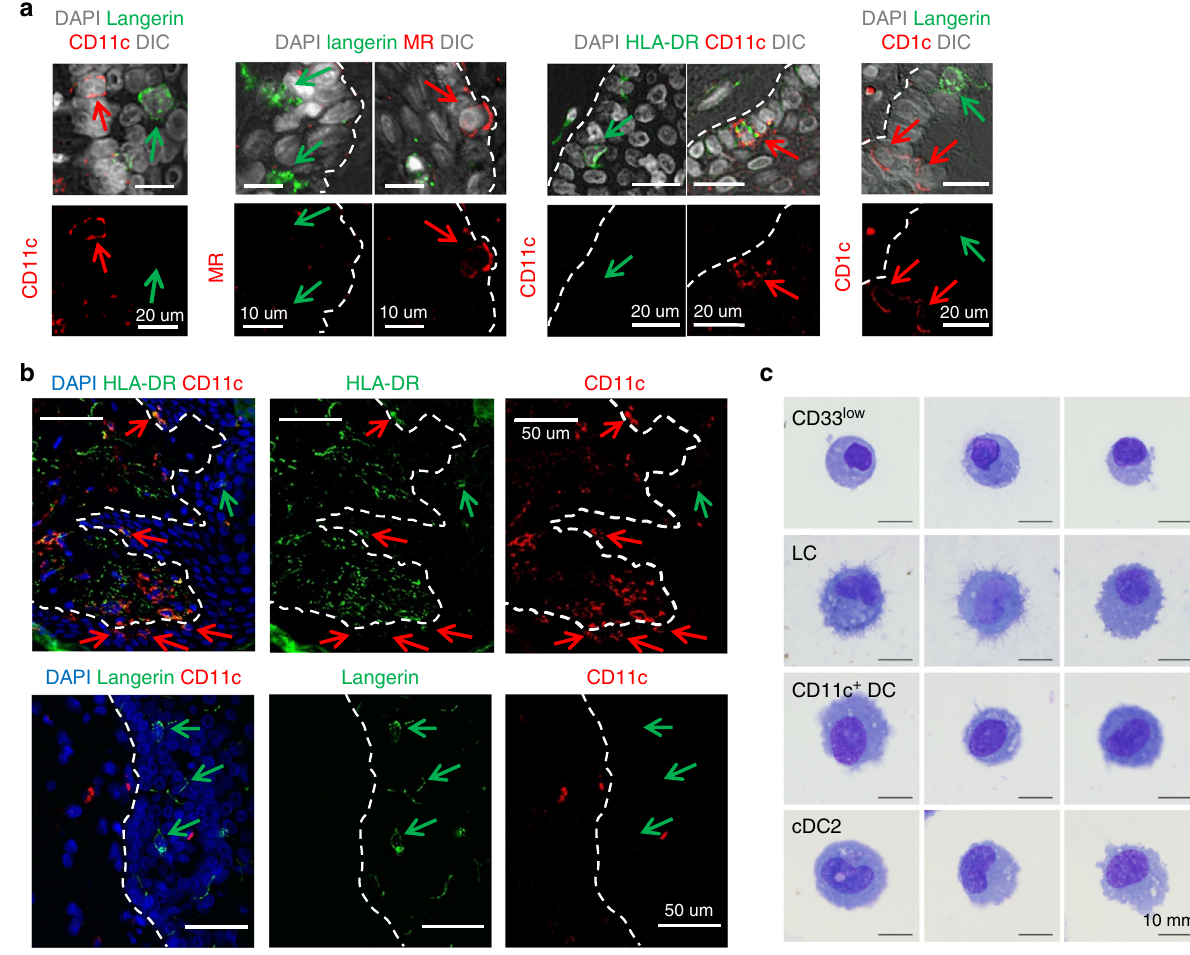
Fig. 3 Visualisation of CD11c + dendritic cells in situ and morphological staining of epidermal MNPs. a , b Human abdominal tissue was sectioned and stained for HLA-DR, CD11c, CD1c, MR and langerin for fl uorescence microscopy. All images representative of at least 3 different donors. a Epidermal CD11c + DCs could be discerned from LCs by their expression of MR, brighter expression of CD1c and CD11c and lack of langerin expression. b Epidermal CD11c + DCs (white arrows) could be discerned from LCs (red arrows) in situ as HLA-DR + , CD11c bright cells and were almost always situated close to the basement membrane. c Epidermal sheets were digested with collagenase Type IV and each epidermal HLA-DR + CD45 + MNP population was FACS sorted and a Giemsa stain carried out for morphological